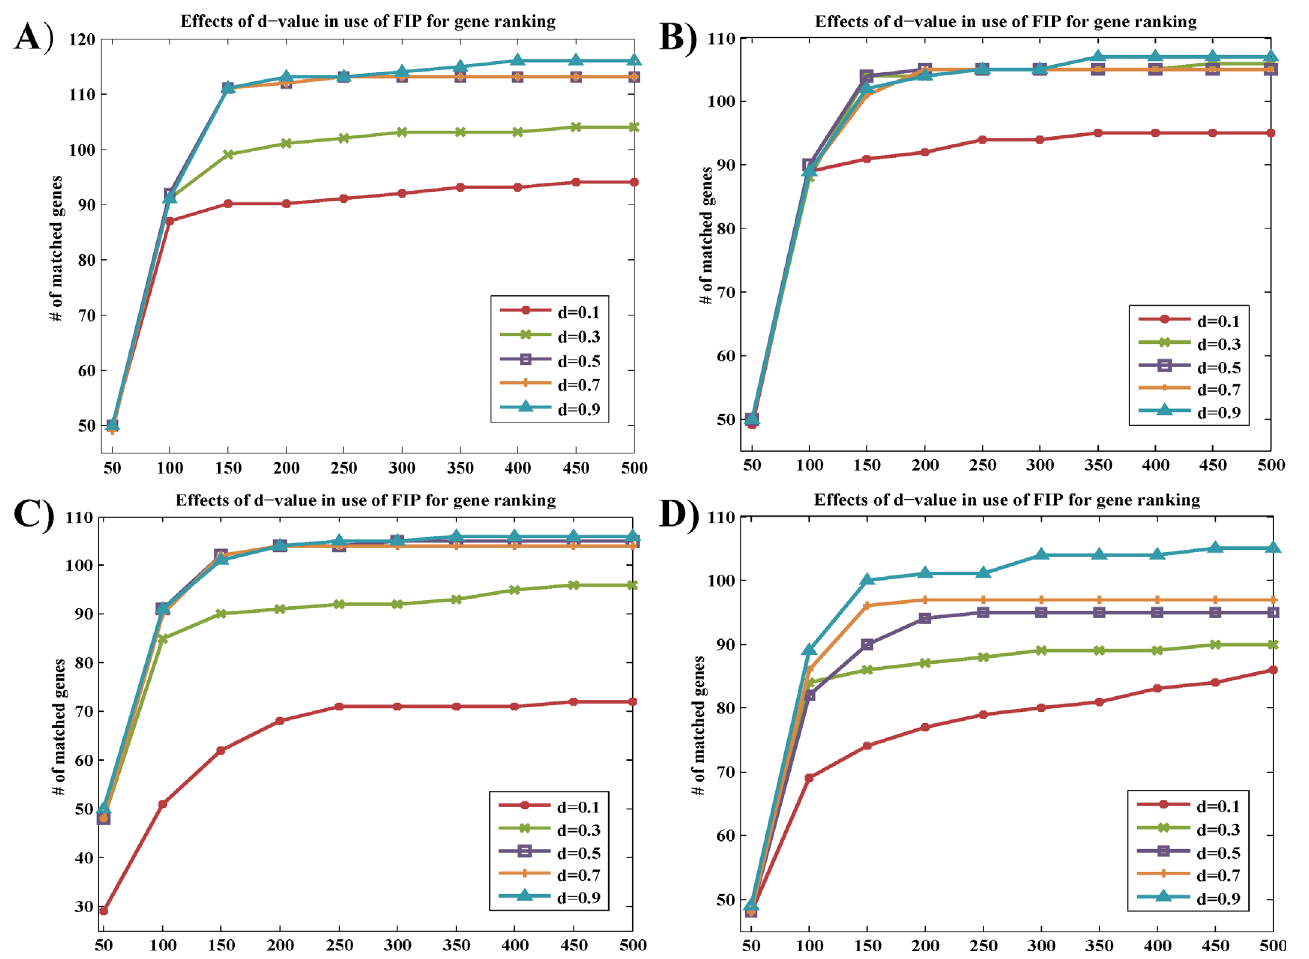
Fig 4. Comparison of performance of FIP-based gene ranking with different d values for four parameter combinations. The number of matched genes identified using FIP with five different d values (d = 0.1, 0.3, 0.5, 0.7, and 0.9) for four parameter combinations were counted and plotted ((A) α = 0.8, β = 0.5, γ = 0.9; (B) α = 0.7, β = 0.5, γ = 0.8; (C) α = 0.9, β = 0.5, γ = 0.8; (D) α = 0.9, β = 0.6, γ = 0.8). Y-axis: the number of matched genes identified using FIP; X-axis: the number of ranked